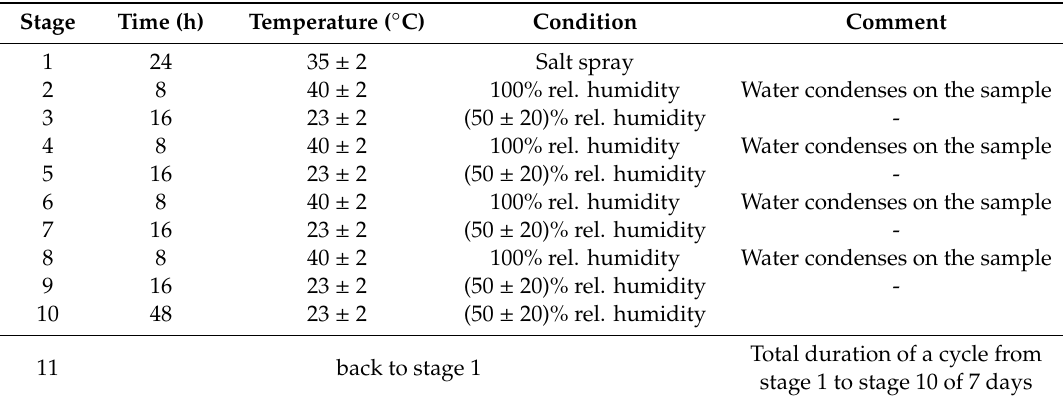
Table 2. Climate-parameters for the cyclic corrosion test; cycle B according DIN EN ISO 11997-1: Stage, duration time, temperature, condition, and